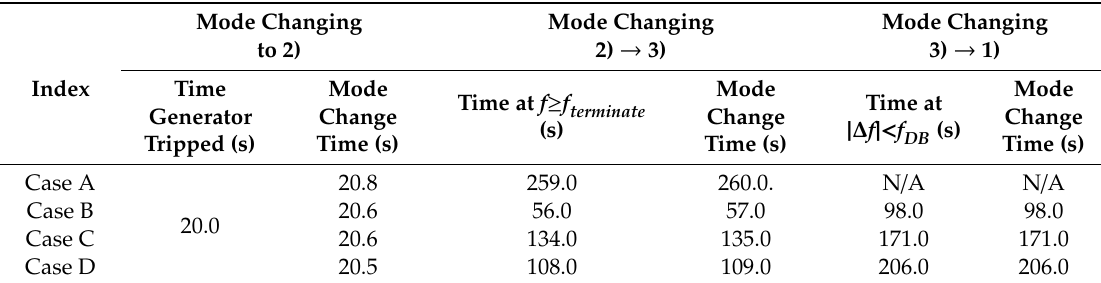
Table 5. Evaluation result of the control strategy.